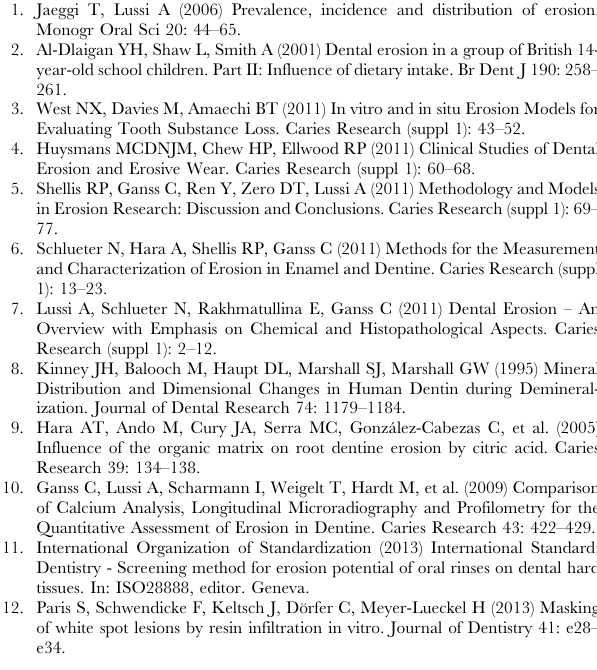
Table S2 Stepwise discriminatory analysis. Measurement methods were analysed for their discriminatory power to distinguish between groups 1 and 3, or groups 3 and 4. Model fit was analysed using canonical correlation coefficients (r) and X 2 - test. Standardized canonical discriminant function coefficients were reported for methods